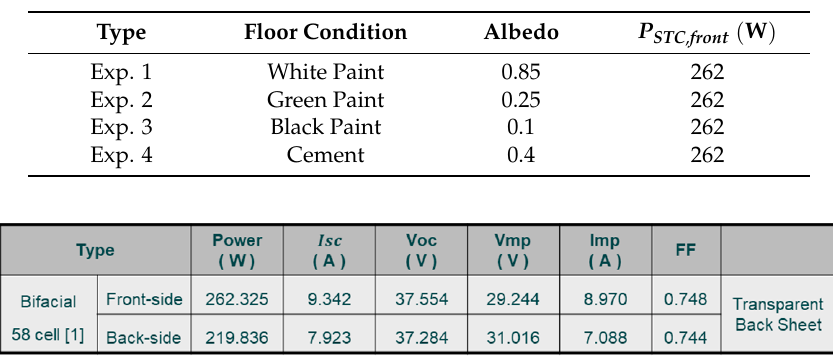
Figure 6. Output parameters of the module used under Standard Test Condition ( STC ).